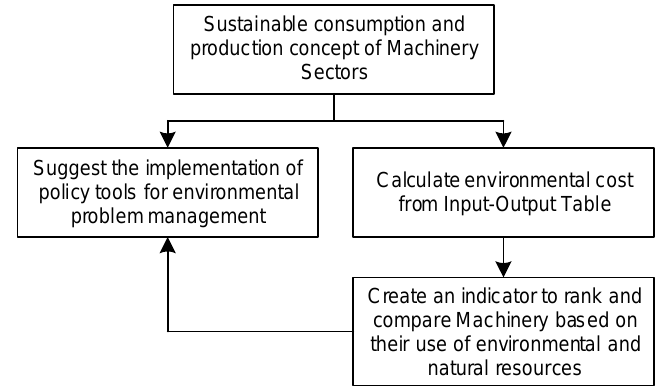
Fig. 2. Conceptual